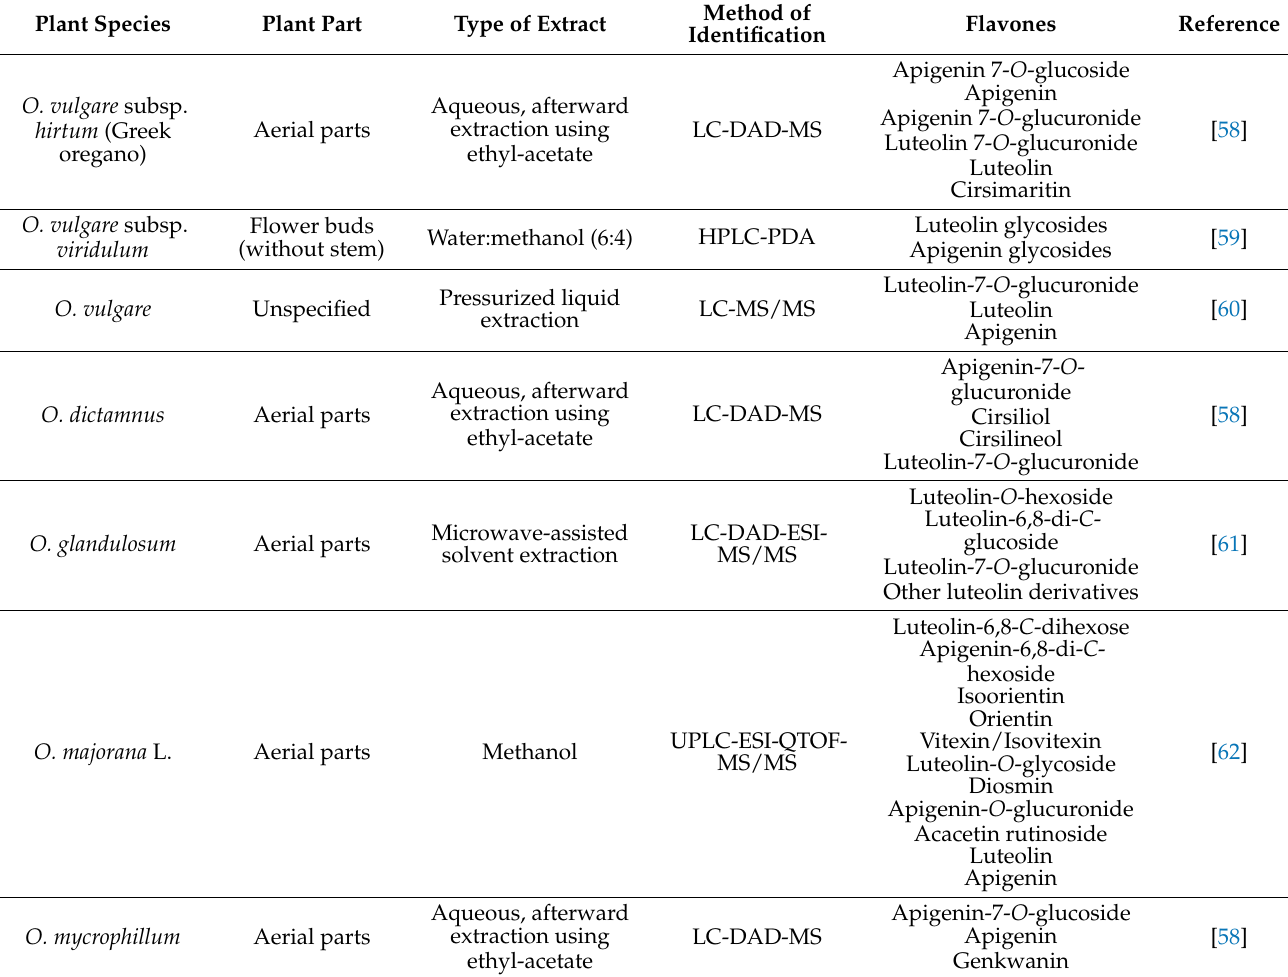
Table 1. Flavones identified in several Origanum